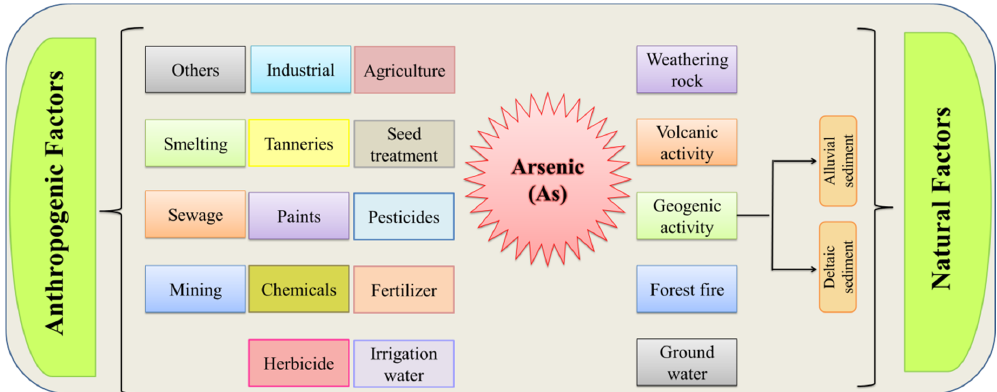
Figure 1. Sources of arsenic contamination in soil.